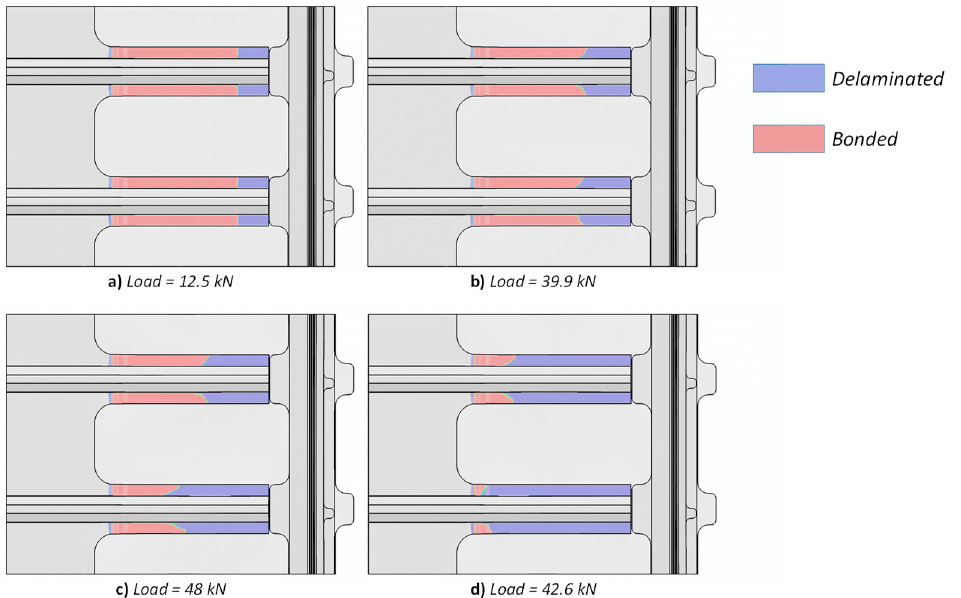
Figure 25. Load vs. applied displacement.